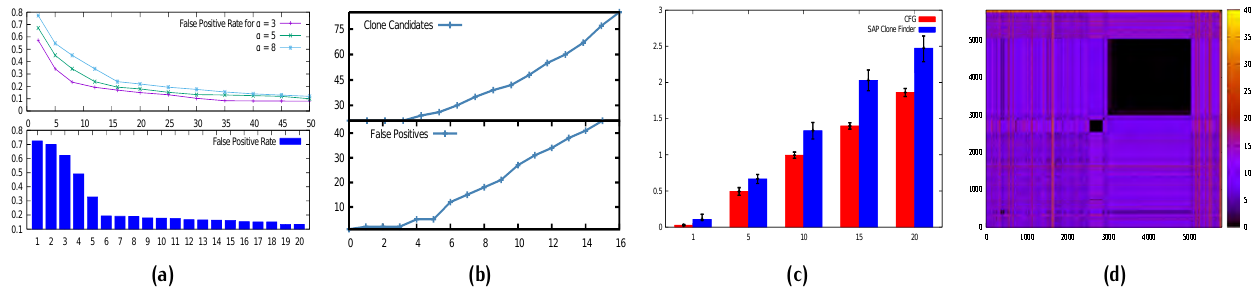
Figure 5. Detection Results: (a) False positives as a function of the number of LoC (Top), False positives as a function of the number of blocks (Bottom); (b) Clone candidates identified for α (Top), False positives for α (Bottom); (c) Time it takes to query for clones in our approach; and (d) Similarity Matrix Heat